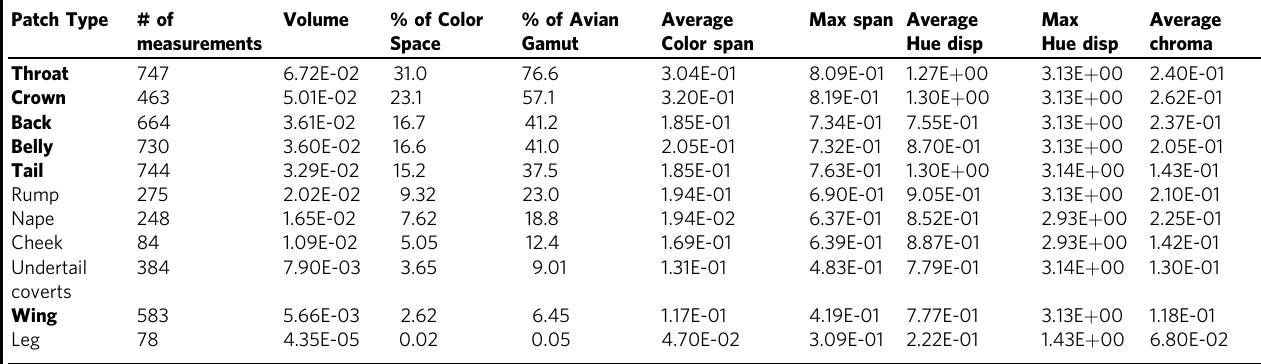
Table 3 Summary of VS color measurements for each patch type. Patch